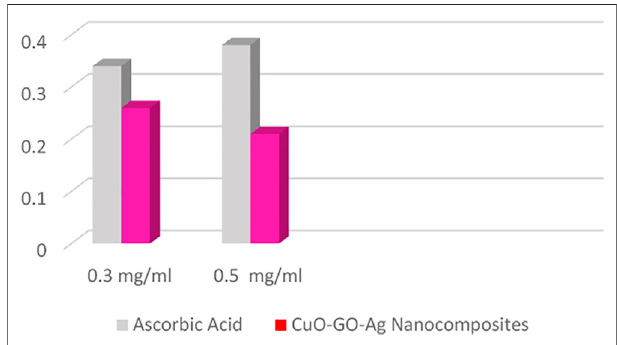
FIGURE 10 | Comparison between IC 50 of ascorbic acid and CuO-GO- Ag